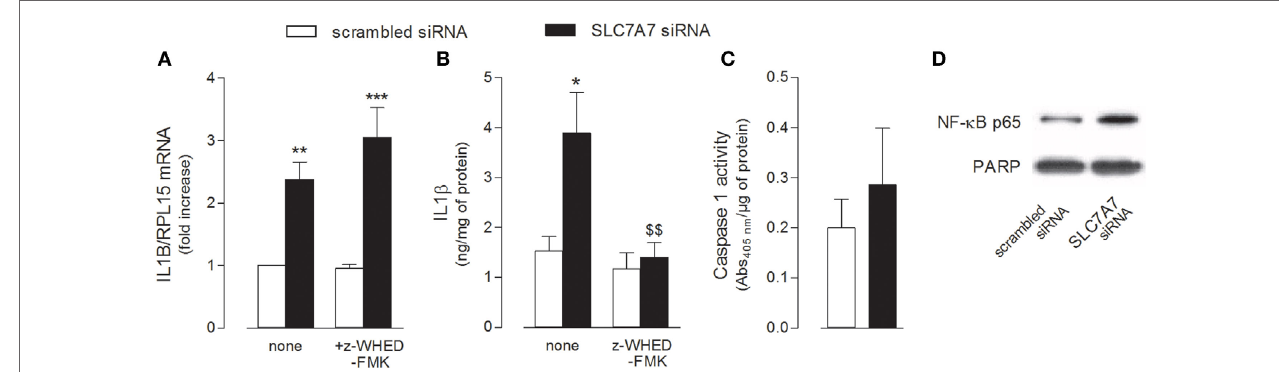
FigUre 3 | THP-1 cells, routinely grown in the presence of 1 mM extracellular arginine, were transfected for 96 h with scrambled or SLC7A7 short interference RNA (siRNA) during PMA-induced differentiation, as described in Section “Materials and Methods”; when indicated, gene silencing was performed in the absence (none) or in the presence of caspase-1 specific inhibitor (z-WHED-FMK). (a–c) The expression of IL1B mRNA was determined with RT-RT-qPCR (a) , IL1 β release was measured with ELISA assay (B) , and the activity of caspase-1 was determined as described in Section “Materials and Methods” (c) . Data are mean ± SEM of three different determinations, each performed in duplicate. * p < 0.05, ** p < 0.01, *** p < 0.001 vs . scrambled siRNA; $$ p < 0.01 vs. SLC7A7 siRNA with one-way ANOVA followed by Bonferroni post hoc test. (D) The amount of NF κ B-p65 in the nuclear fraction was monitored with Western Blot analysis. The experiment was repeated twice with comparative results; a representative blot is